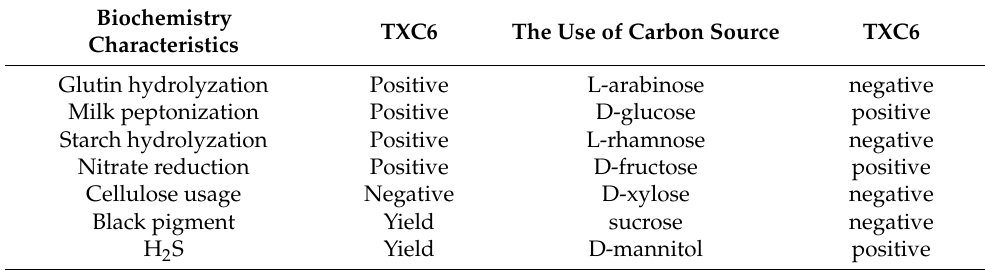
Table 2. Physiological and biochemical properties of